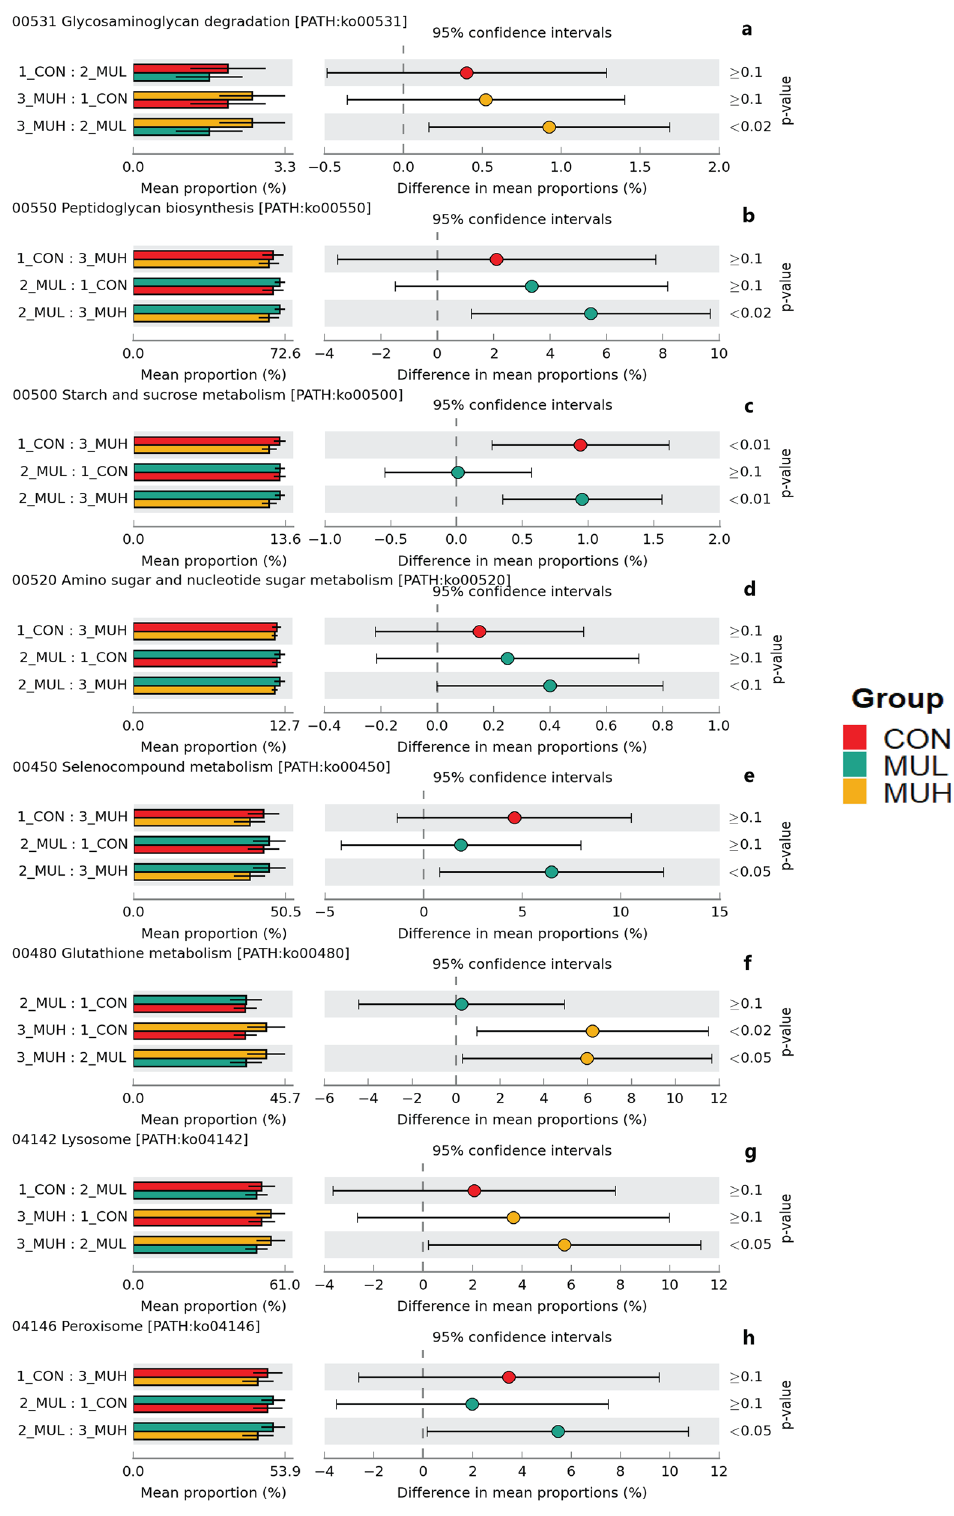
Figure 10. Extended error bar plots of mean relative abundance differences of glycan biosynthesis and metabolism ( a , b ), carbohydrate metabolism ( c, d ), metabolism of other amino acids ( e, f ), and transport and catabolism ( g, h ) between caecal samples of CON, MUL, and MUH at slaughter (42 d). Colored bars and black lines indicate the mean relative abundance and standard deviation of the KEGG level 3 path, respectively (left side). Colored dots inside the 95% confidence intervals signify the difference of mean relative abundance of the KEGG level 3 path for each pairwise comparison (center). Games-Howell post-hoc test p -values are reported (right